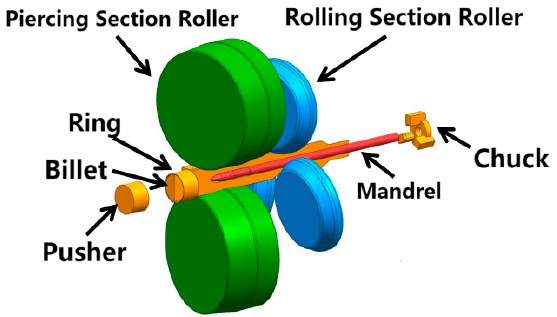
Figure 27. Tandem flexible skew rolling [37] (Reprinted from ref. [37]).